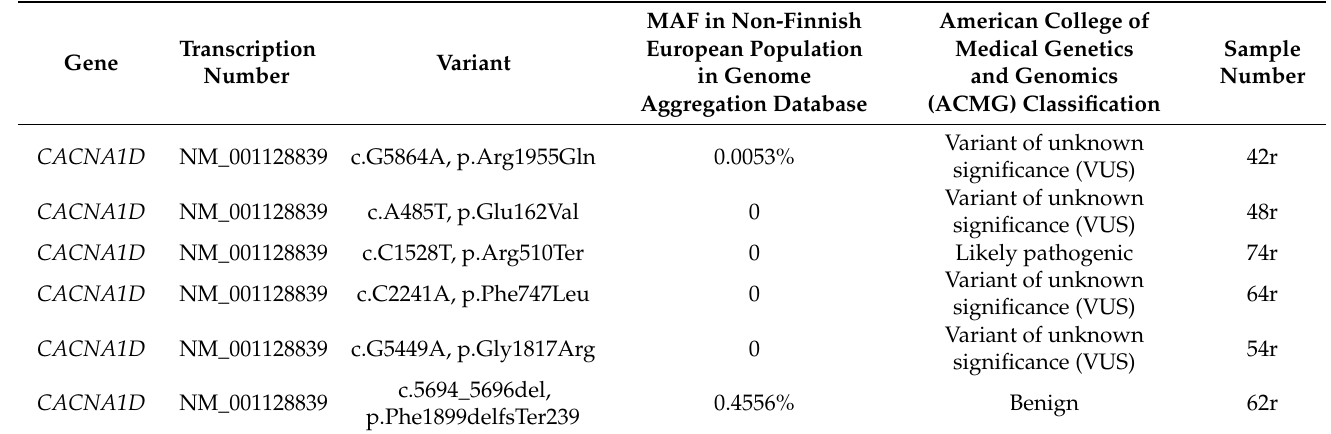
Table 1. Identified CACNA1D variants of 21 ALS